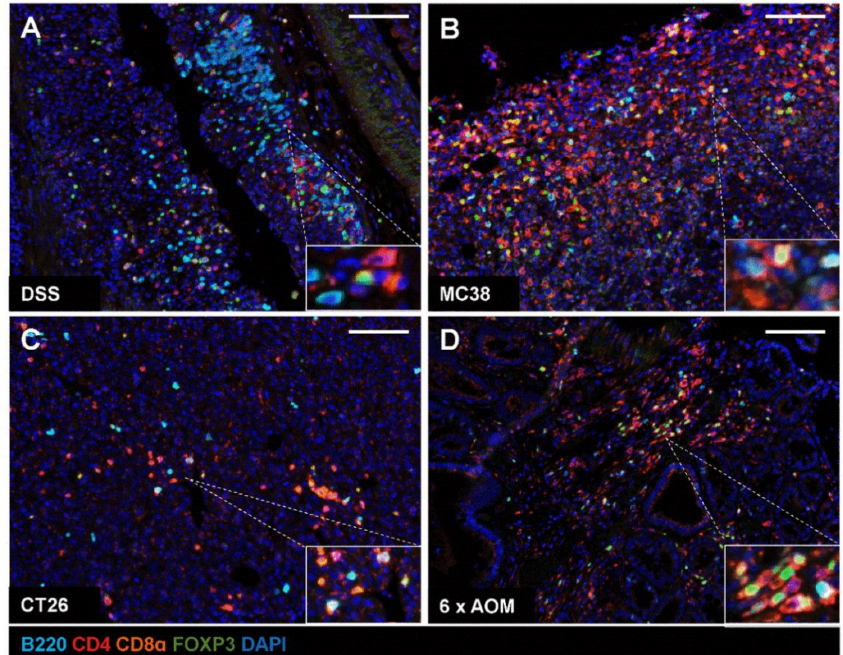
Figure 5. Application of the optimised multiplex staining panel in murine disease and cancer models. Multiplex staining was performed on the colon of mice treated with 3.5% dextran sulphate sodium (DSS) ( A ). Staining was also performed on mouse models injected with murine colon adenocarcinoma cells (MC38 or CT26) ( B , C ) or after repeated administration of the colon carcinogen azoxymethane (AOM) ( D ). Tissue sections were imaged at 20X magnification on Vectra 3. B220 (cyan); CD4 (red); CD8 α (orange); FOXP3 (green). Scale bar: 100 µ